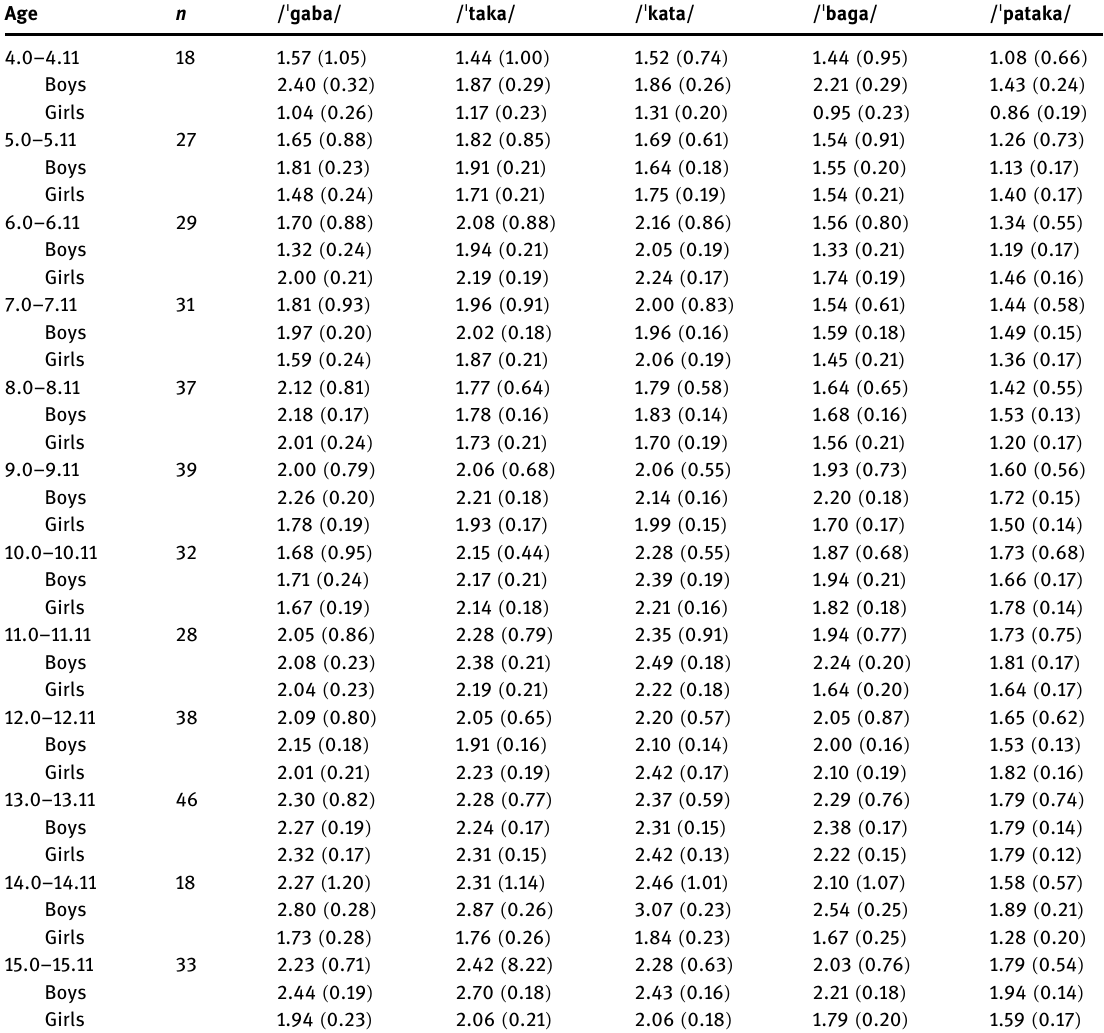
Table A1: Normative data ( mean values ± SDs ) of non - word stimuli repetition per